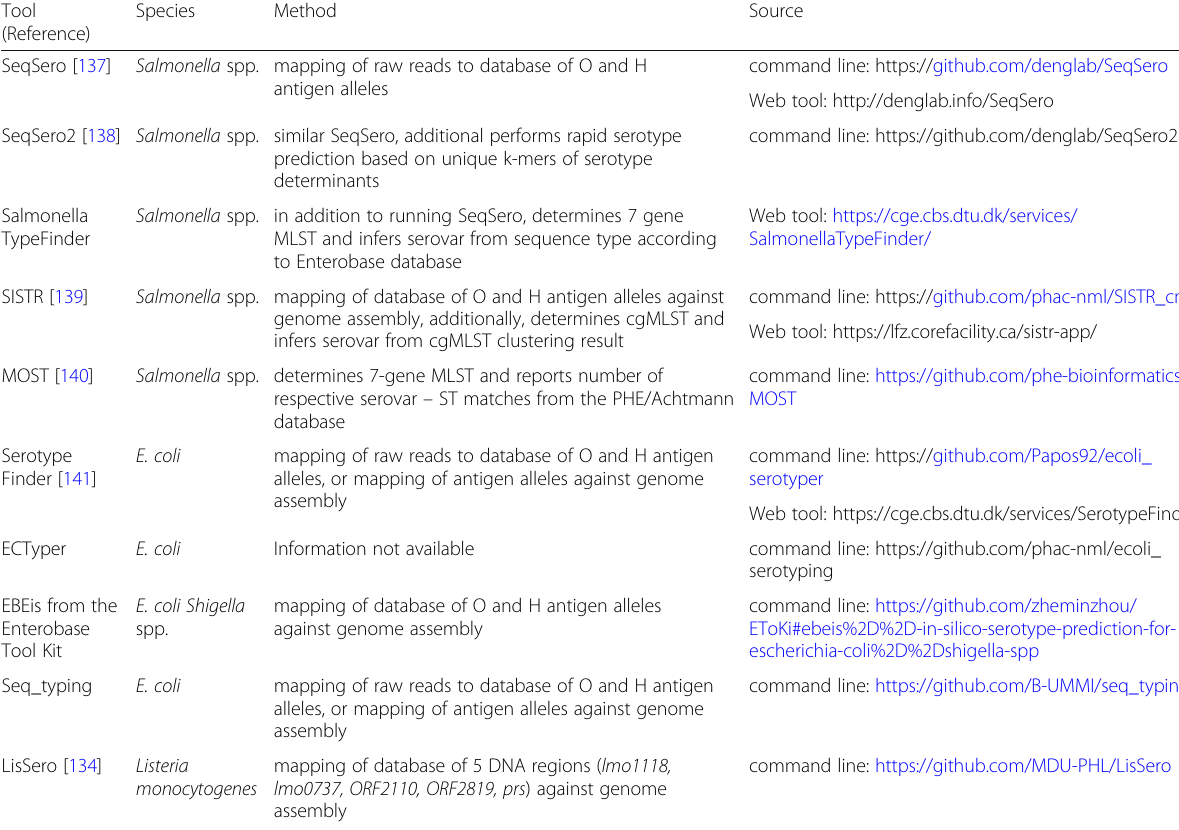
Table 3 List of different tools for in silico serovar prediction Tool